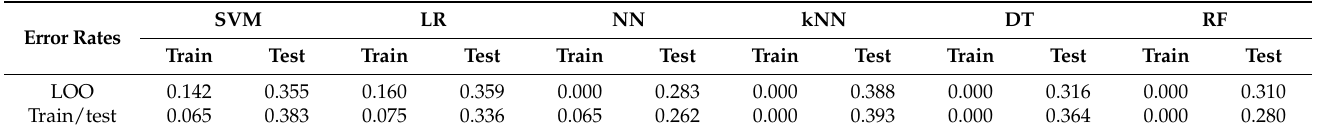
Table 7. Error rates for the MedD data set (default